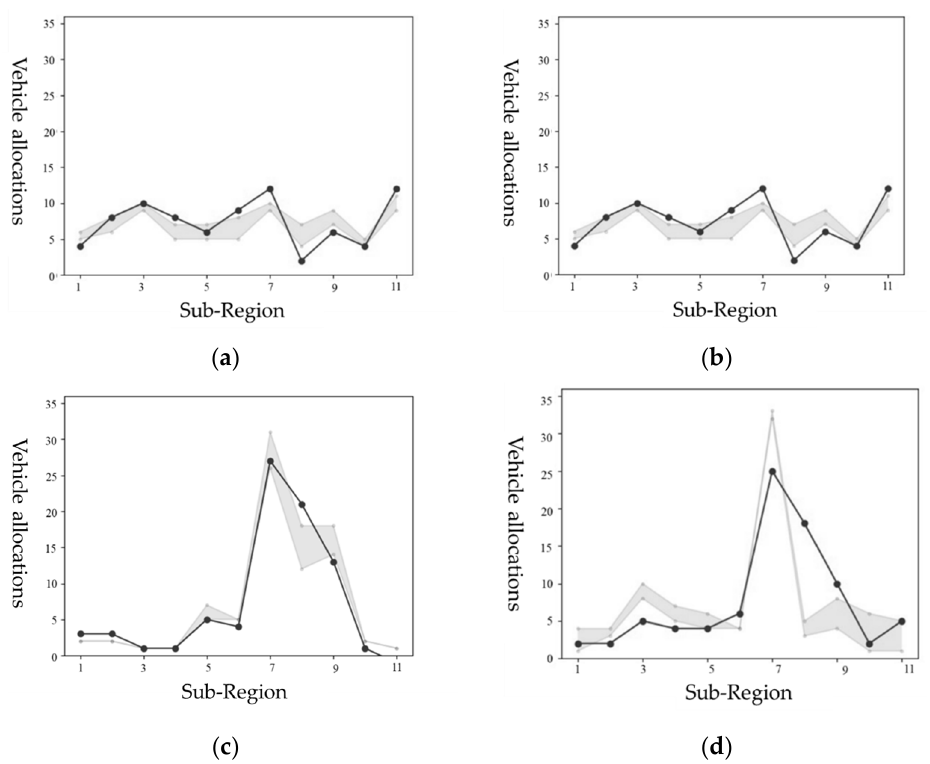
Figure 16. Arena vs. GAN’s Station-Car results in last four cases: ( a ) Case 5, ( b ) Case 6, ( c ) Case 7, ( d ) Case 8.